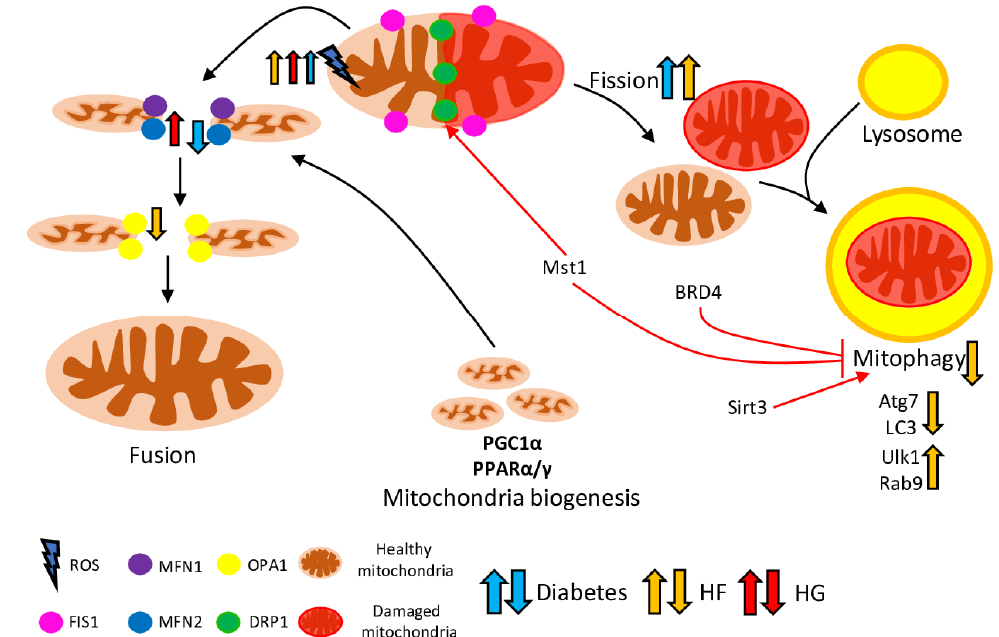
Figure 1. Interconnections between mitophagy, mitochondrial dynamics, and mitochondrial biogenesis in DCM. Damaged and malfunctional mitochondria are isolated via mitochondrial fission, merged with lysosome, and digested through mitophagy. Healthy parts of mitochondria are returned to the mitochondrial network through mitochondrial fusion. Mitochondrial fission is mediated by Drp1 and Fis1, fusion––Mfn1 and 2, OPA1, while conventional mitophagy is guided by Atg7 (Autophagy-Related Protein 7) and LC3 (Autophagy-Related Ubiquitin-Like Modifier LC3 A), and alternative––by Ulk1 (unc51 like kinase 1)- and Rab9 (Ras-related protein Rab-9)-dependent mechanism. The adequate mitochondrial pool is supported via generation of new mitochondria, which is regulated by transcription factors (such as PPARα/γ) and cofactors (such as PGC1α), and sustained the supply of energy to the myocardium. The imbalance between mitochondrial dynamics, mitophagy, and mitochondrial biogenesis leads to metabolic dysregulation and cardiomyocytes’ damage. The effects of the diabetes, high fat (HF), and high glucose (HG) conditions on the key players are depicted with blue, yellow and red arrows, respectively.